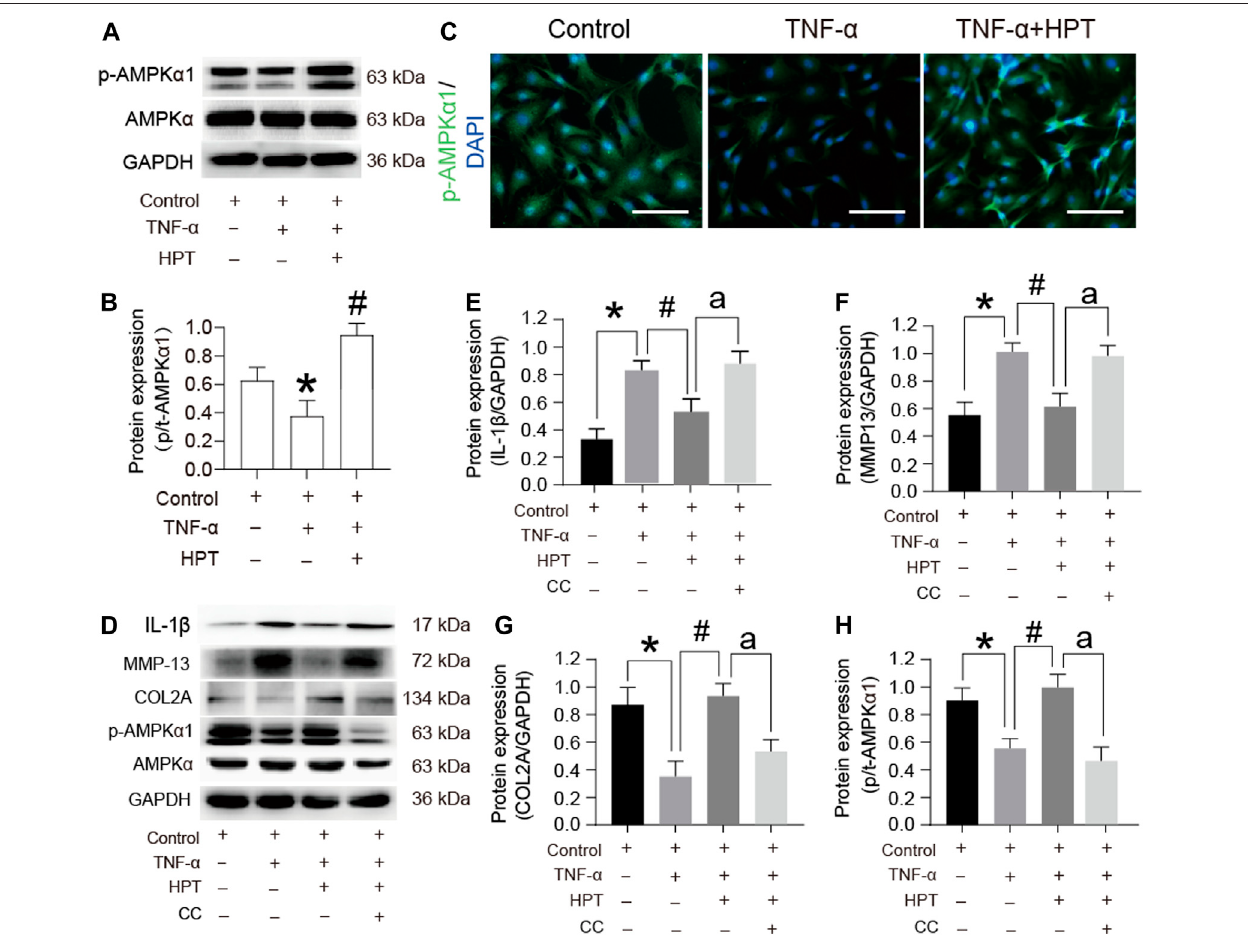
FIGURE 5 | AMPK signaling pathway participates in the protective effect of HPT on TNF- α -stimulated rat chondrocytes. (A, B) Protein expression pro fi le of p-AMPK α 1culturedunderTNF- α conditionswithorwithoutHPT. (C) Immuno fl uorescenceofp-AMPK α 1inchondrocytestreatedwithTNF- α and/orHPT. (D – H) Protein expression pro fi le of IL-1 β , MMP13, COL2A, and p-AMPK α 1 cultured under the condition of HPT with or without and TNF- α with or without CC. For statistical analysis, * p < 0.05 was considered as a signi fi cant difference from the control group; # p < 0.05 was considered as a signi fi cant difference from TNF- α . a P < 0.05 was considered as a signi fi cant difference from TNF- α +